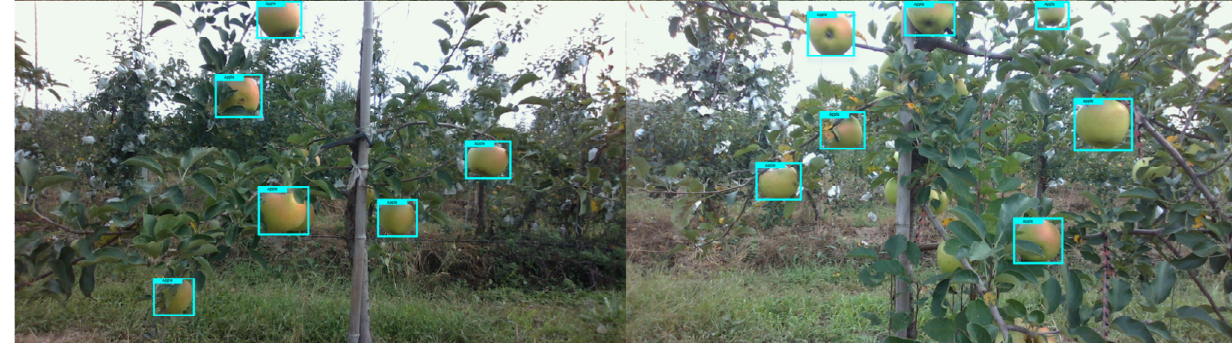
Figure 5. Apple recognition renderings using the YOLOv3 neural network.